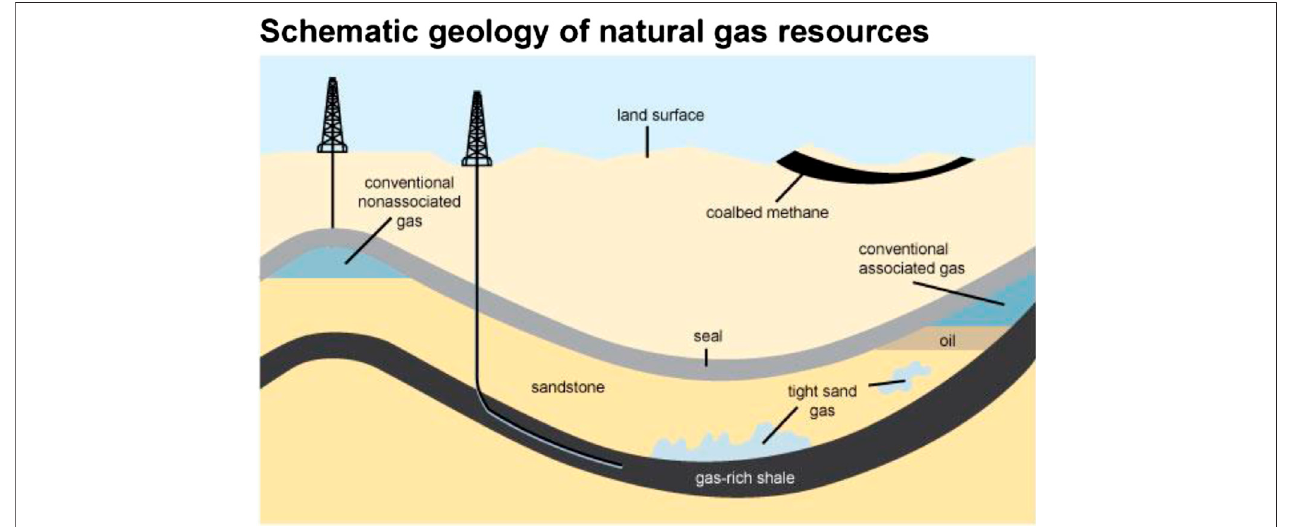
FIGURE 2 | Schematic geology of natural